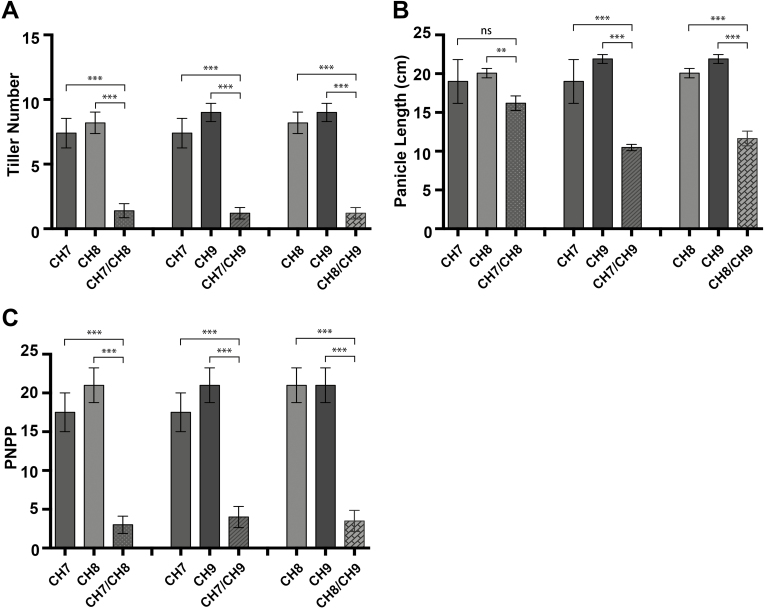
Comparison of yield components in the parents and their F1 progeny exhibiting hybrid weakness at the maturity stage. Comparison of tiller number (A), panicle length (B) and panicle number per plant (PNPP) (C) between parents and their F1 exhibiting hybrid weakness. Significant difference determined by the one-way-ANOVA: **P<0.01, ***P<0.001; ns, P>0.05).